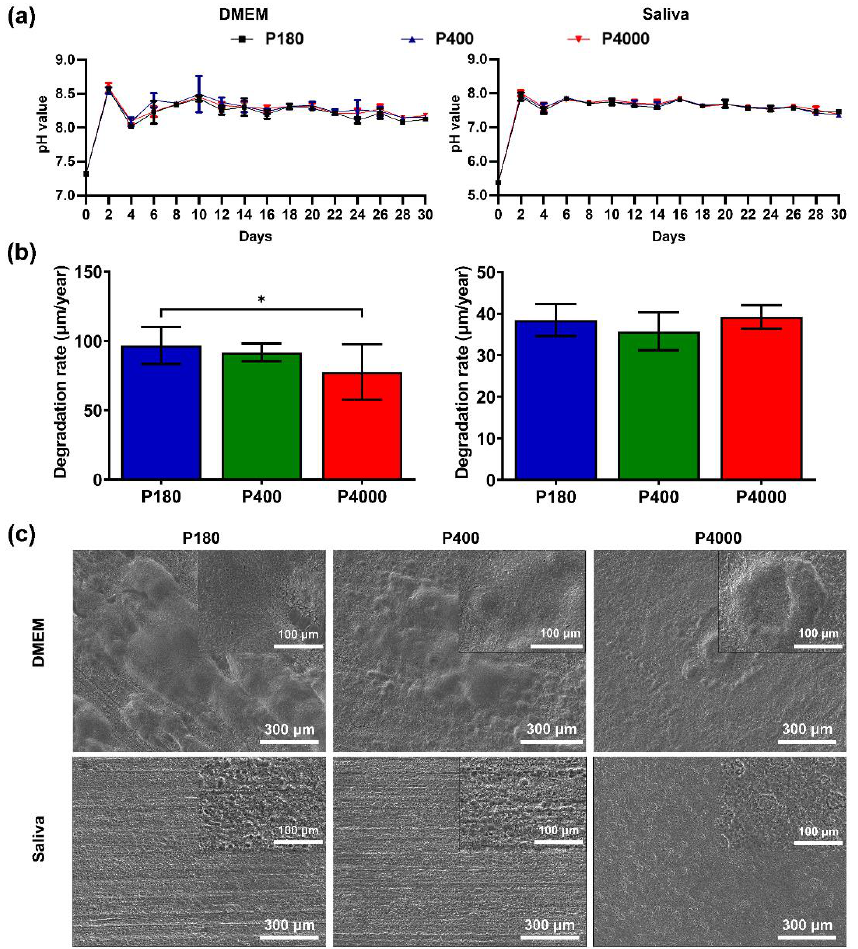
Figure 3. Degradation behavior of pure Mg samples with gradient surface roughness attributes. ( a ) pH value change of simulated body fluid and artificial saliva for 30 days, respectively. ( b ) Degradation rate ( μm /year) calculated by weight loss of samples after 30 days of immersion in DMEM and artificial saliva under cell-cultured conditions, where * represents a statistical difference between the two groups. ( c ) Surface morphology of samples after removal of corrosion products. Representative magnification 100 × of SEM images and the insets show the magnification 500 × of SEM im- ages.